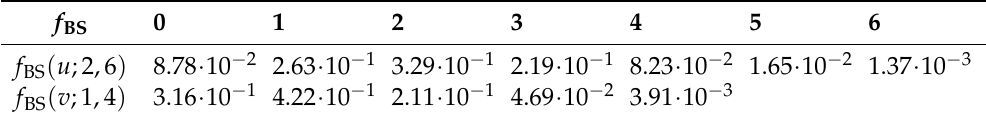
Table 2. Example: probability mass functions for x = 2, y = 1, m = 6 and n = 4 bivariate binomial experiment